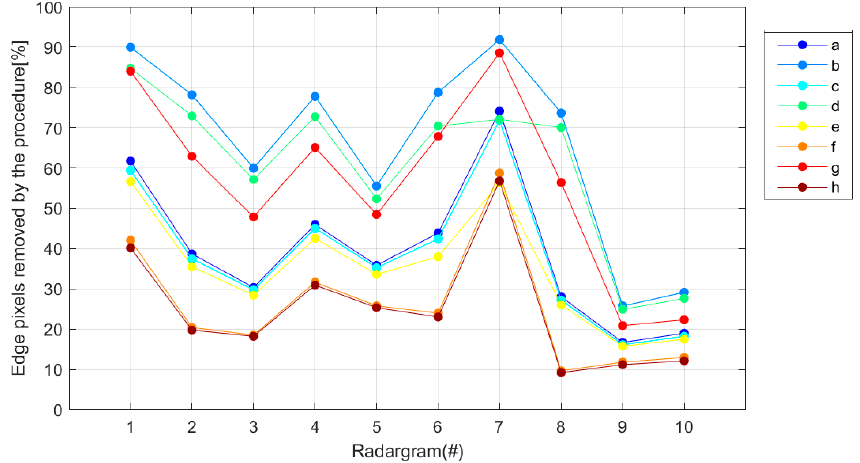
Figure 10. Percentage reduction of edge pixels using the condition proposed in sub-section 2.3, with the various search zones depicted in Figure 4.